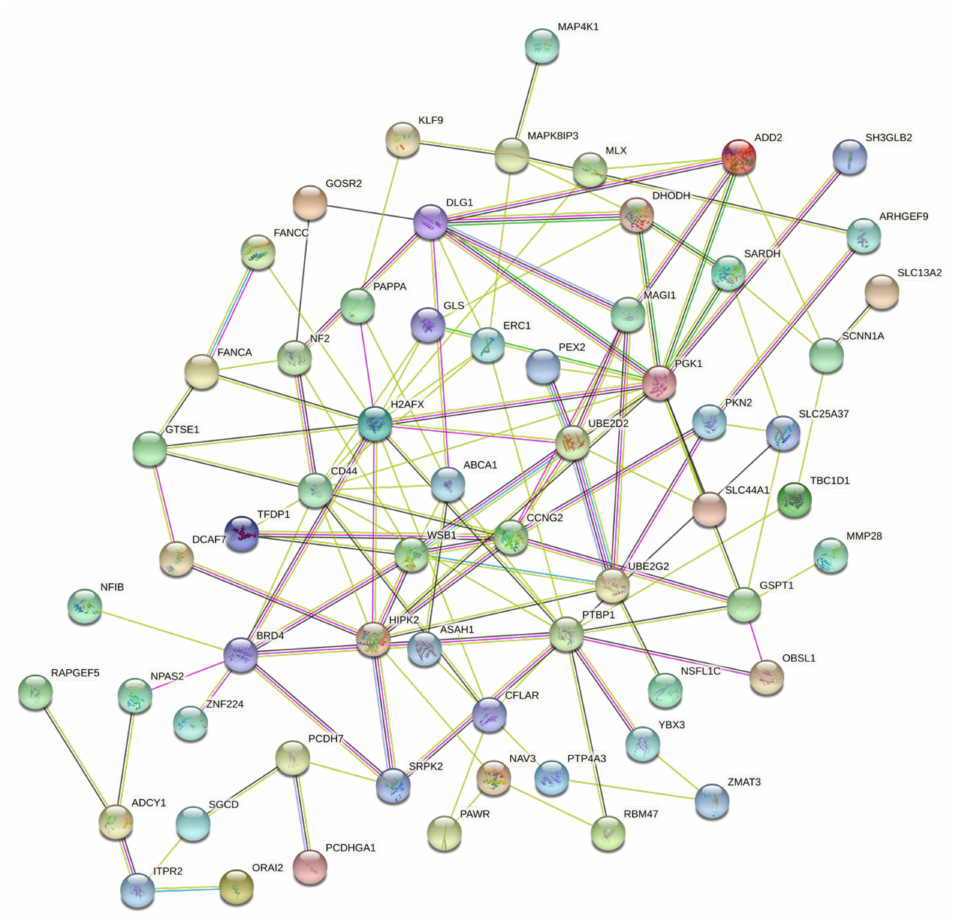
Figure 9. STRING PPI network observed for the 66 differentially expressed genes after pesticide exposure in the 6 datasets